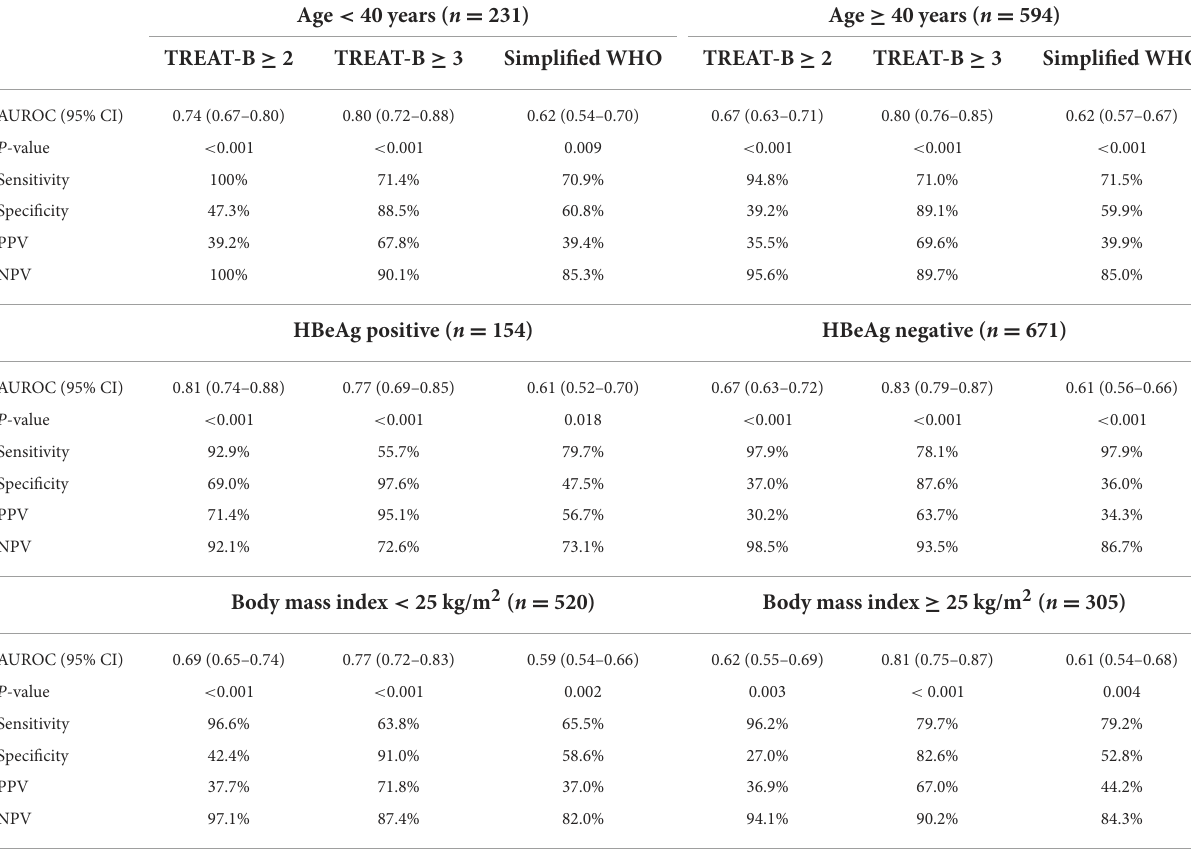
TABLE 3 Performance of TREAT-B and Simplified WHO to select patients eligible for anti-HBV therapy in subgroup of